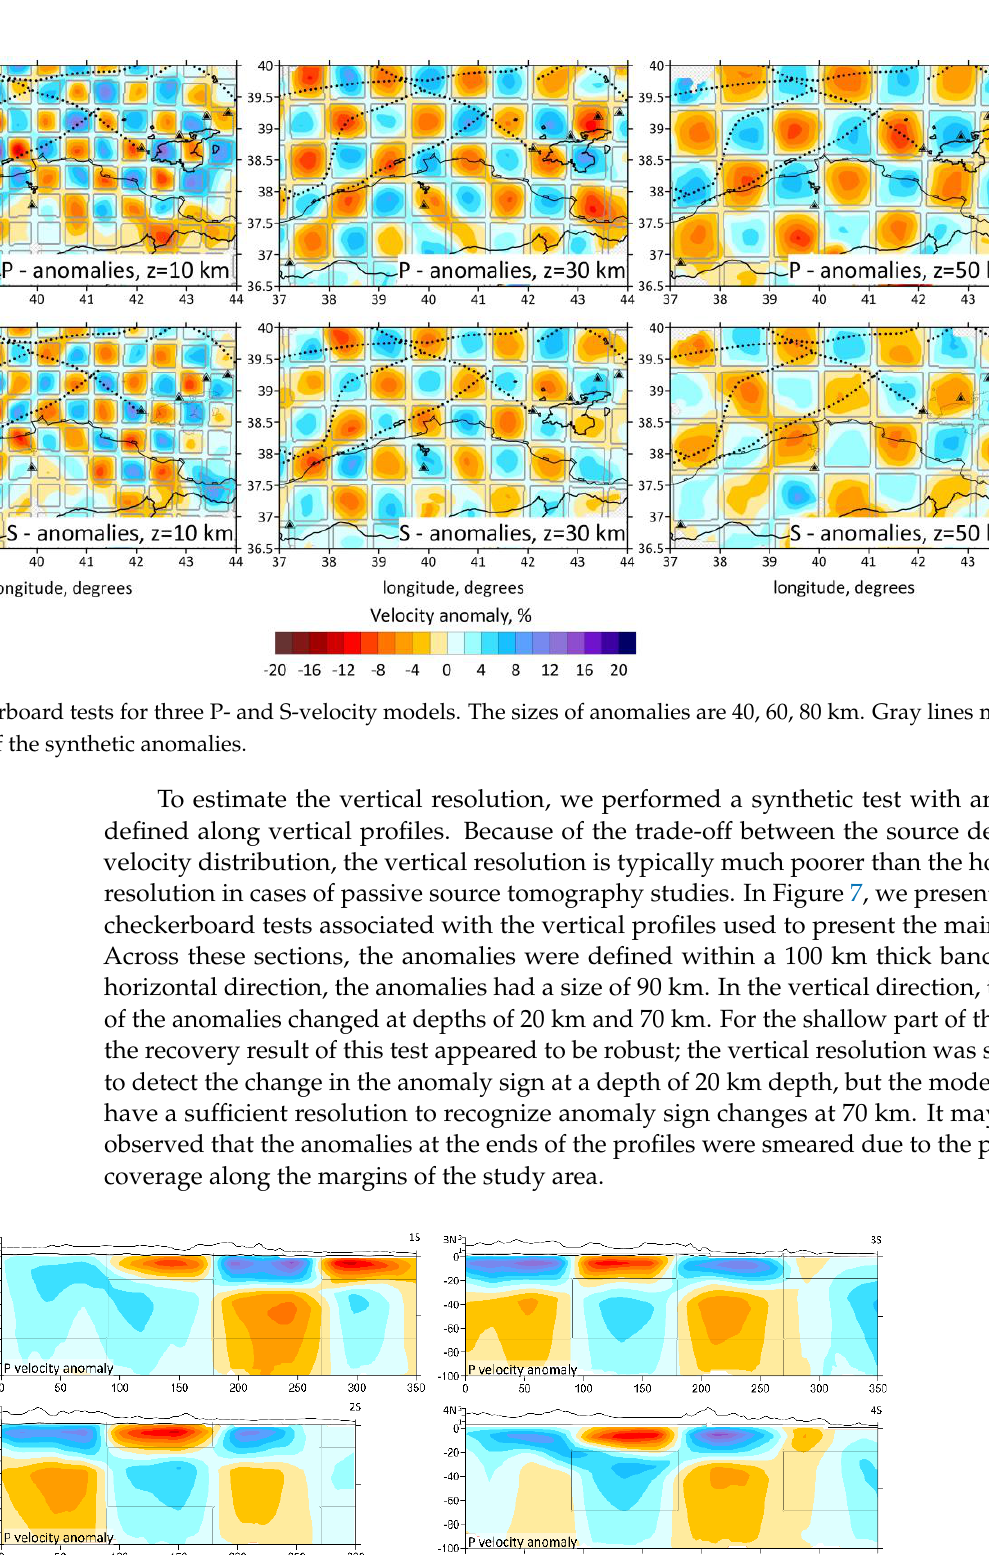
Figure 7. Vertical checkerboard test.